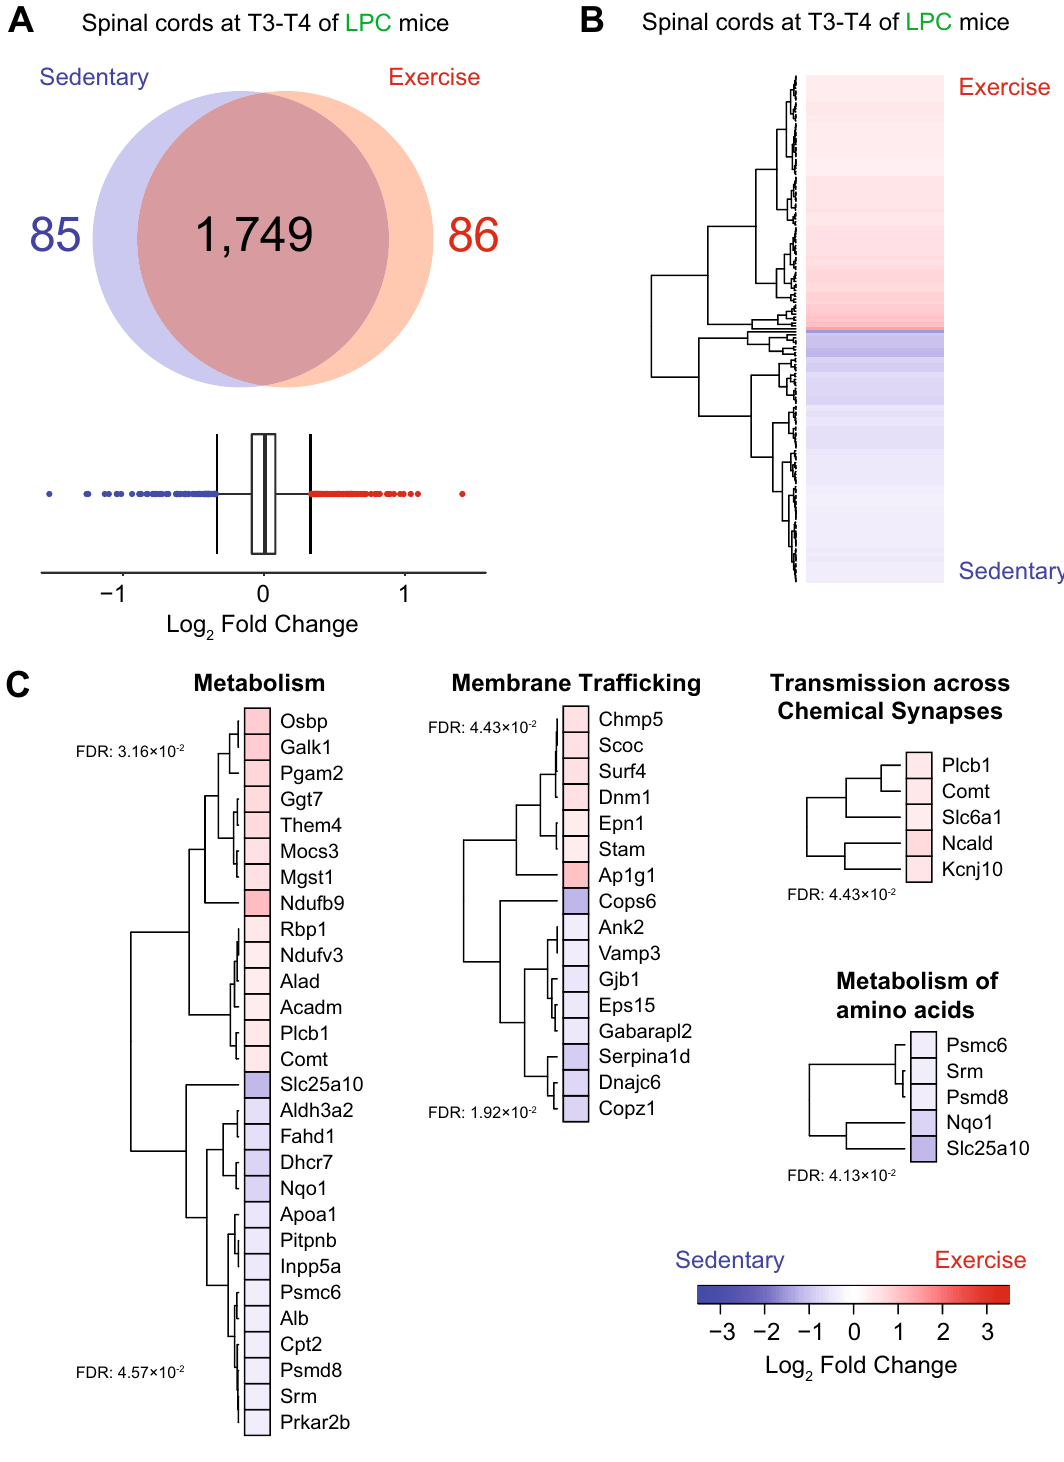
Figure 4. Effect of exercise on LPC demyelinated spinal cord proteome after 4 days of running wheel. ( A ) Quantification of differentially expressed proteins in LPC demyelinated spinal cord 4 dpi as determined by interquartile box plot analysis. A false discovery rate (FDR) of 1% was applied to the database search on MaxQuant. ( B ) Heatmap of differentially expressed proteins in LPC demyelinated spinal cord. C ) Heatmap of proteins and associated reactome pathways as determined by STRING (https:// string- db. org). A false discovery rate (FDR) for each pathway was added on the left of each heatmap. Interquartile box plot analysis was used for statistics. Data analysis was accomplished using the R software 32 . The plot was generated using the heatmap.2 function from the gplots package 34